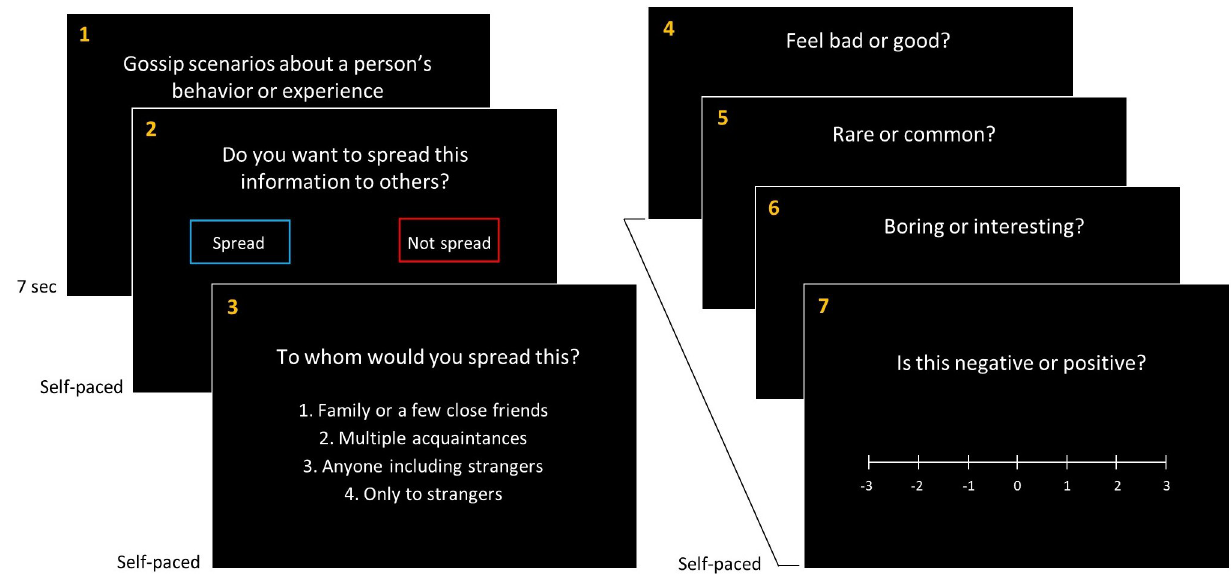
Fig 3. Experimental procedures. The experimental task involved a total of seven screen displays on a computer monitor: (1) a gossip scenario was shown for seven seconds; (2) participants were then asked to decide whether or not to spread the given information to other people by pressing buttons on a keyboard; (3) if they chose to spread the gossip, they were given four options of gossip receivers: family members or a few close friends, multiple acquaintances, anyone including a total stranger, and strangers only, with receiver type to be examined in a future article; and (4)-(7) the participants were then asked to rate each scenario (from -3 to +3) on emotion (4), ordinariness (5), interest level (6), and subjective valence (7).